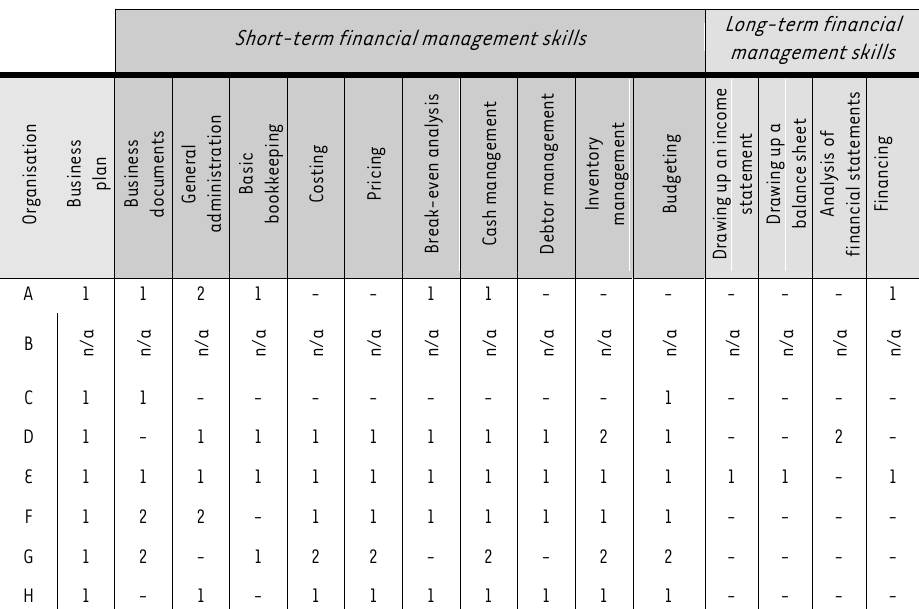
TABLE 5: Financial management topics covered in training courses Short-term financial management skills